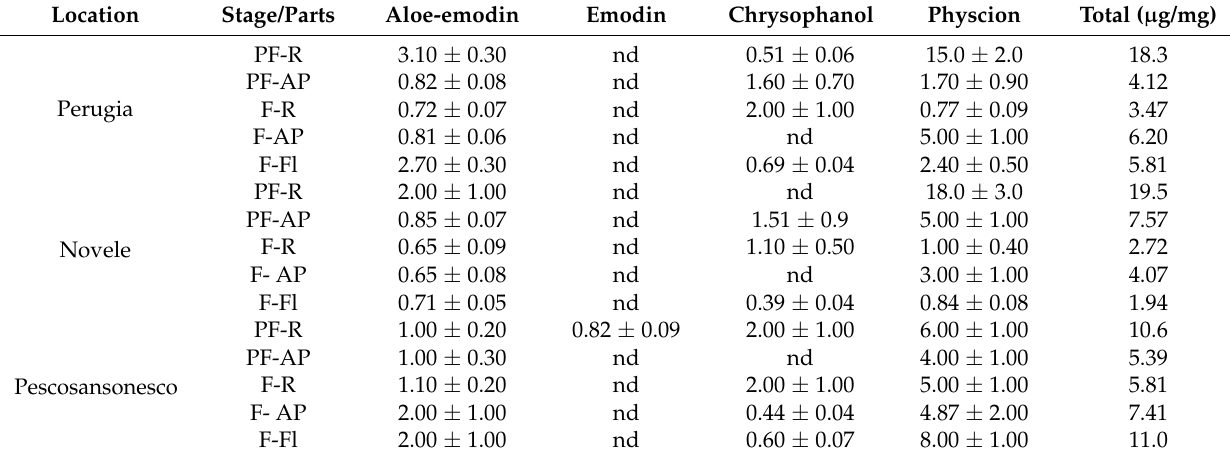
Table 3. Anthraquinone profiles of different parts of A. lutea collected from three different locations in Italy *.